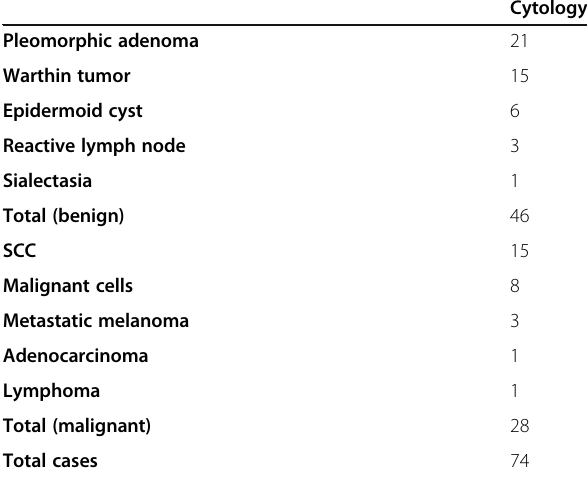
Table 1 Cytological diagnosis and final histological diagnosis